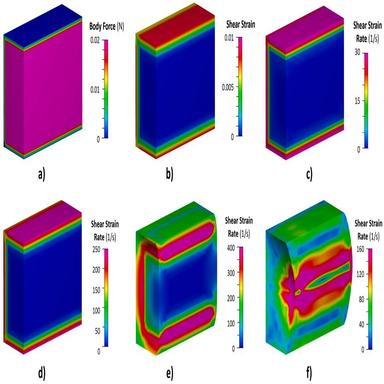
a) Body force for initial stiffening effect at 0.3 ms, b) shear strain at 0.3 ms, and c)-f) rate of shear strain at 0.3 ms, 0.5 ms, 1.5 ms and 3.5 ms respectively for half of the gel block of Sylgard 3–6636 (1:2) with an impact velocity of 2.40 m/s.